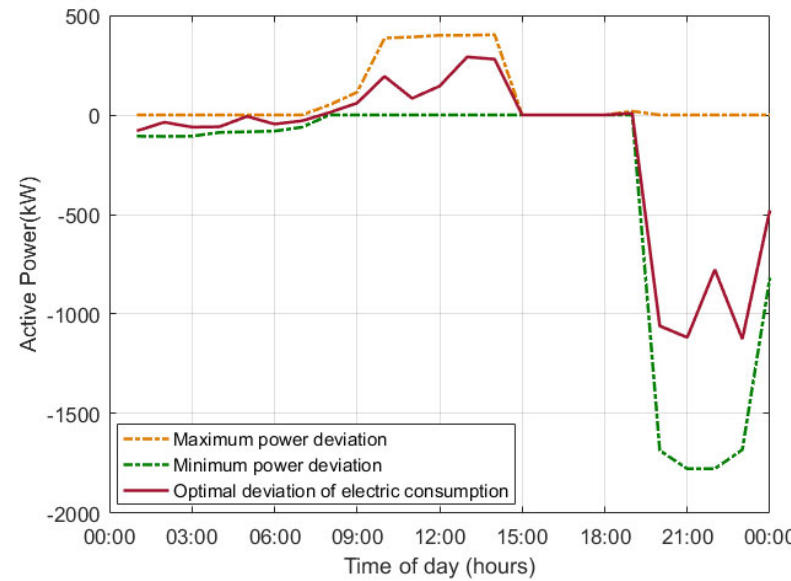
Figure 17. Optimal deviation of the power transferred between the microgrid and the active distri ‐ bution network.